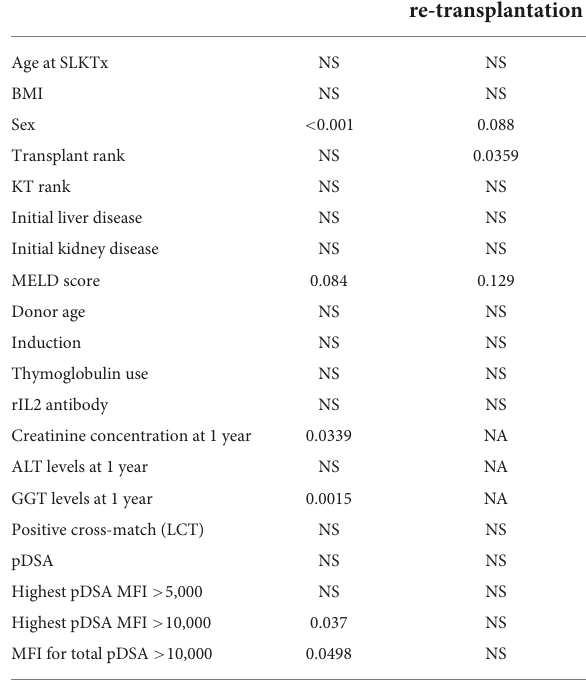
TABLE 5 Factors associated with death, early death, and/or